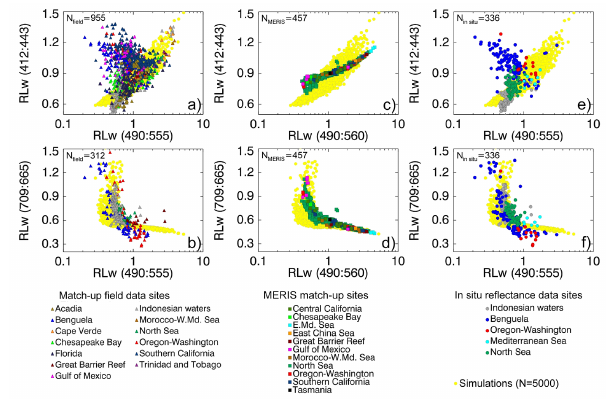
412:443 (a) and vs. RLw band ratio 709:665 (b) within the match- up field data set, RLw band ratio 490:560 vs. RLw band ratio 412:443 (c) and vs. RLw band ratio 709:665 (d) within the MERIS RLw products of the match-up data set, and in the in situ reflectance data set (e, f) . The yellow circles represent the simulated data